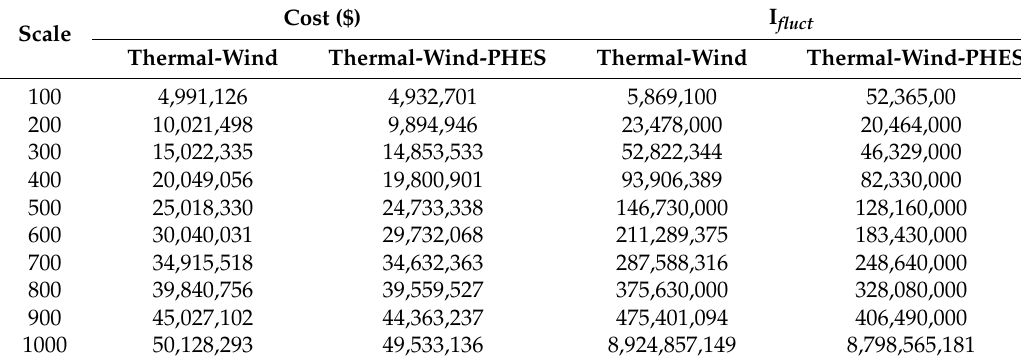
Table 7. Comparison of the improved MILP of UC problems results in different hybrid systems.